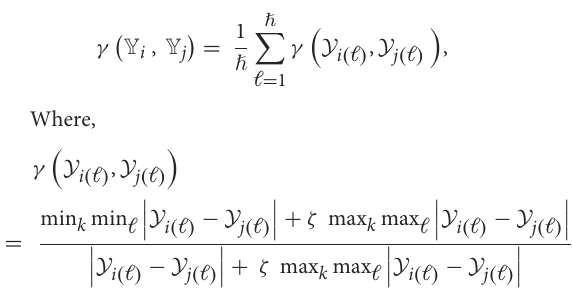
Y Y and can be Absolute GRA model i , j (cid:0) (cid:1)